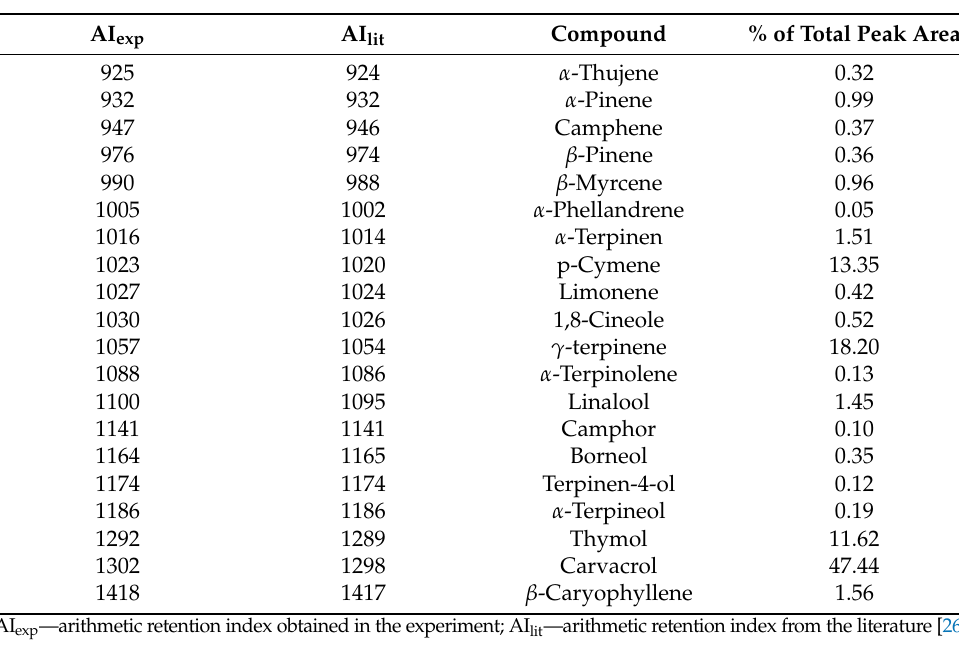
Table 1. The main constituents (% of total peak area) of HerbELICO essential oil mixture determined by GC-MS.